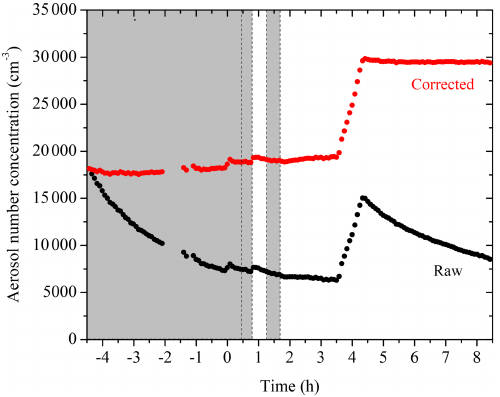
Figure 1. SMPS-measured (black symbols) and size-dependent particle-wall-loss-corrected (red symbols) aerosol number concen- tration evolution during a typical experiment (Exp. 1). Ozone was added into the chamber at time zero to initiate α -pinene ozonolysis. The shaded areas indicate that the chamber was dark. The dashed lines mark the beginning and the end of the two times HONO were added. The increase in number concentration at t = 3.5h is due to the injection of 5gL − 1 of ammonium sulfate particles. An addi- tional 100cm − 3 of particles was formed due to nucleation at both the ozonolysis step and the aging step. Data were not recorded from t =− 2 to −